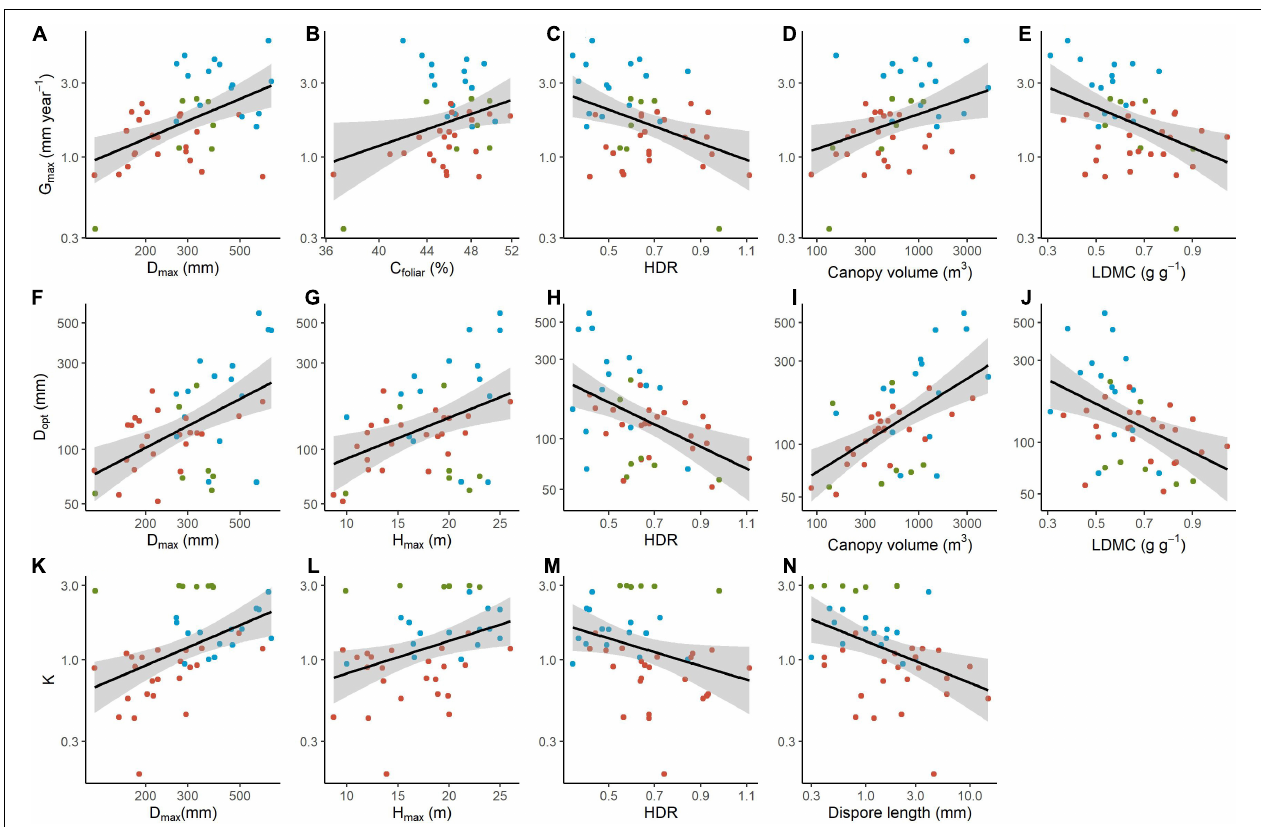
FIGURE 3 | Relationship between growth parameters and traits measured for 45 tropical tree species. (A–E) Maximum growth rate (G max ); (F–J) Diameter size at maximum growth rate (D opt ); and (K–N) ontogenetic variation in growth rate (K) relationship with maximum species diameter (D max ), maximum species height (H max ) leaf C concentration (C foliar ), height to diameter ratio (HDR), Canopy volume, leaf dry matter content (LDMC) and Diaspore length. All variables were log-transformed before analyses. Only significant regression slopes are shown ( P-value < 0.05). Different colours represent different groups identified by cluster analysis: Cluster 1 (15 species, blue circles); Cluster 2 (23 species, red circles) and Cluster 3 (7 species, green circles). Correlation R 2 and P-values can be found in Table 2